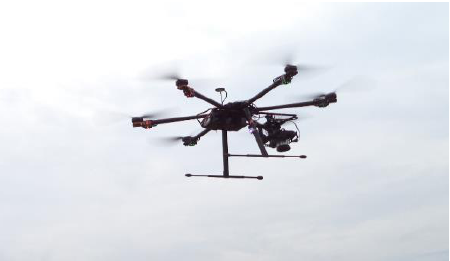
Figure 7. Hexa-copter used for image